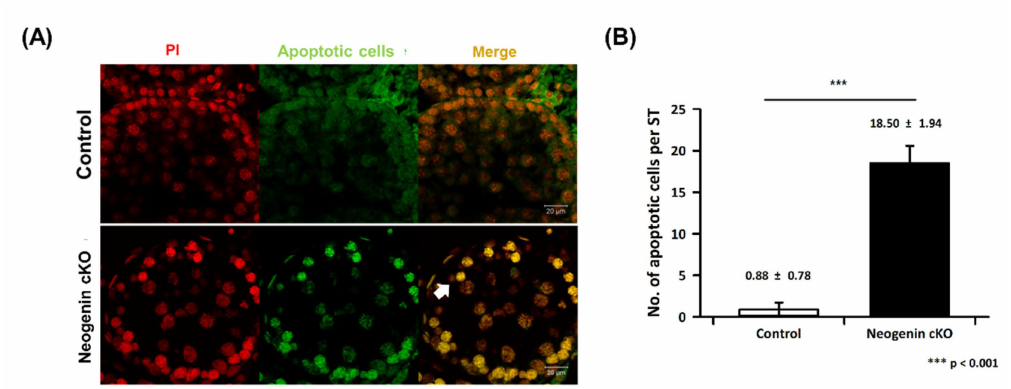
Figure 4. Quantification of apoptotic cell death in seminiferous tubules. Apoptotic death of seminif- erous tubular cells was fluorescently measured using the TUNEL assay as described in the Materials and Methods. ( A ) Images of PI-positive nuclei (red) and apoptotic cells (green) were merged. ( B ) The numbers of apoptotic cells (white arrow) were counted and plotted (n = 10). *** p < 0.001 versus control by the Student’s t